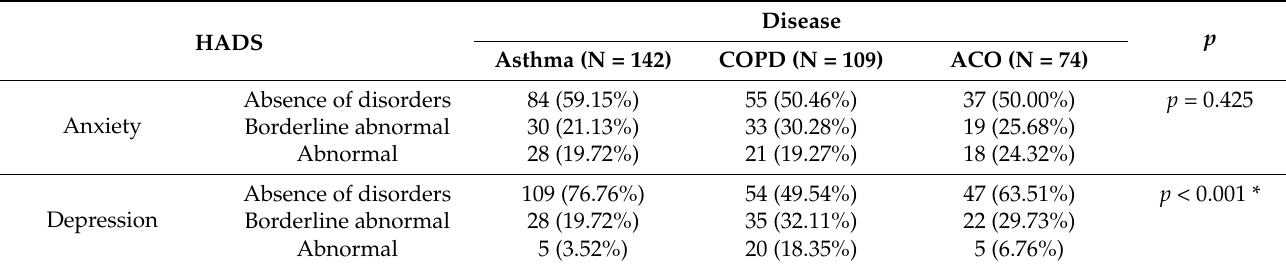
Table 4. HADS anxiety and depression—score